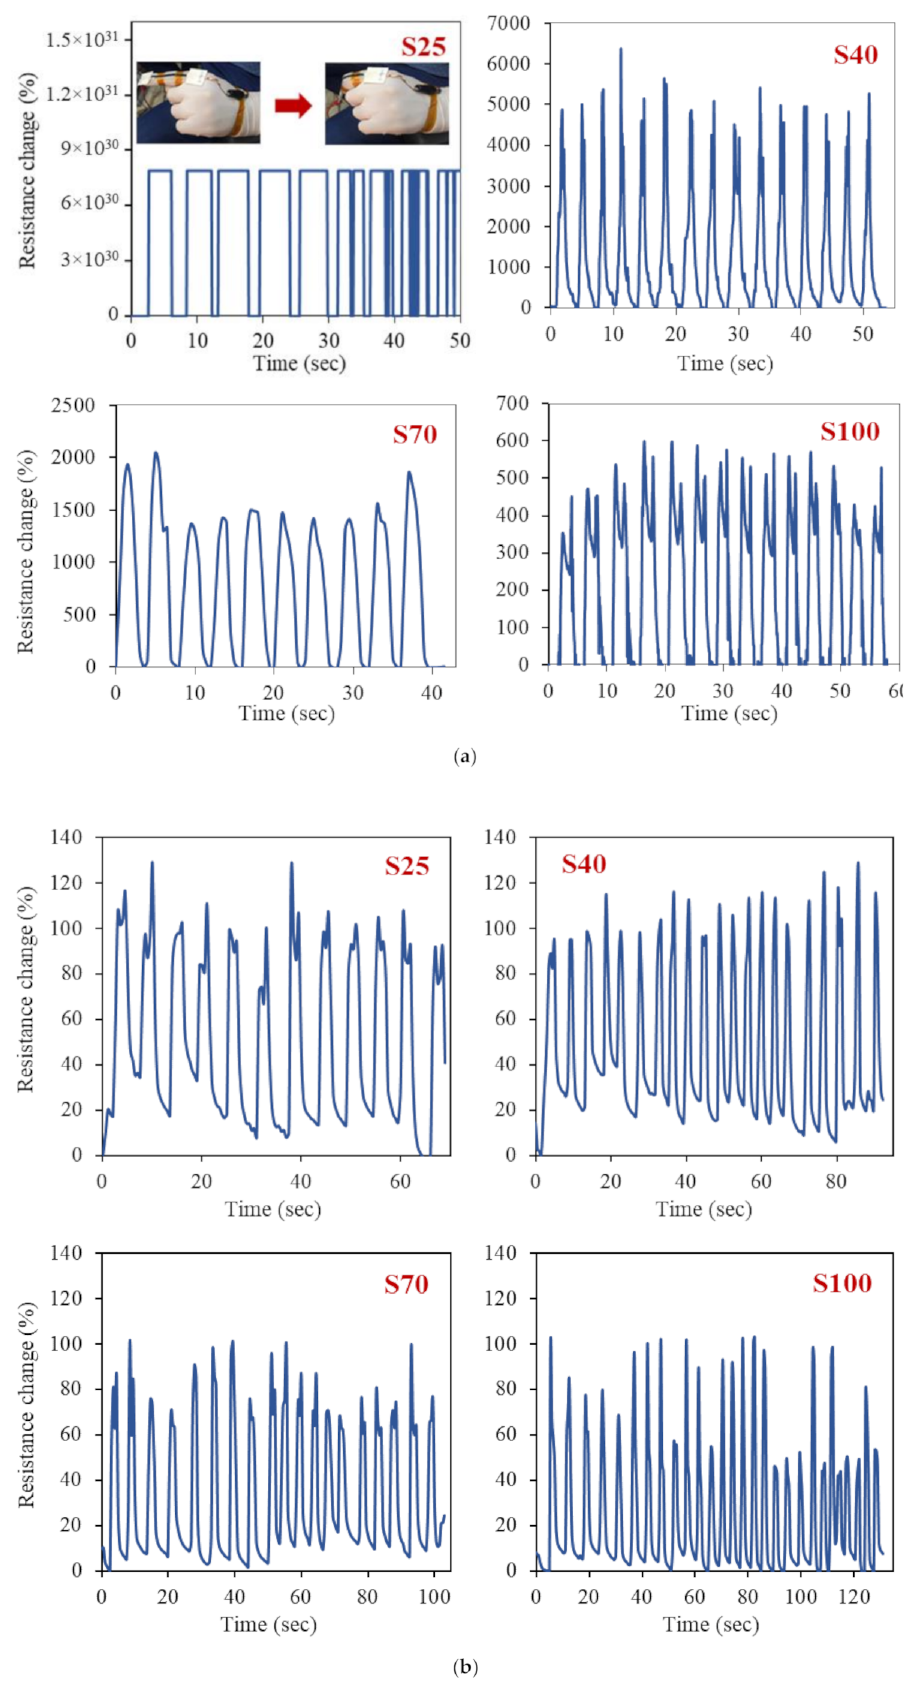
Figure 3. Electrical resistance change of sensors against finger ( a ) and wrist ( b )